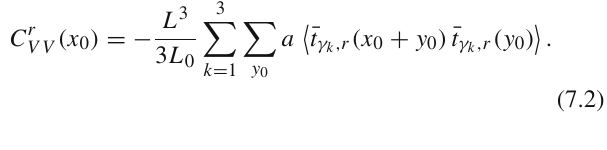
is comparable with the gauge noise after N s ∼ 256. Right: the discon- nected contribution using the split-even estimator from N cfg = 1200 gauge